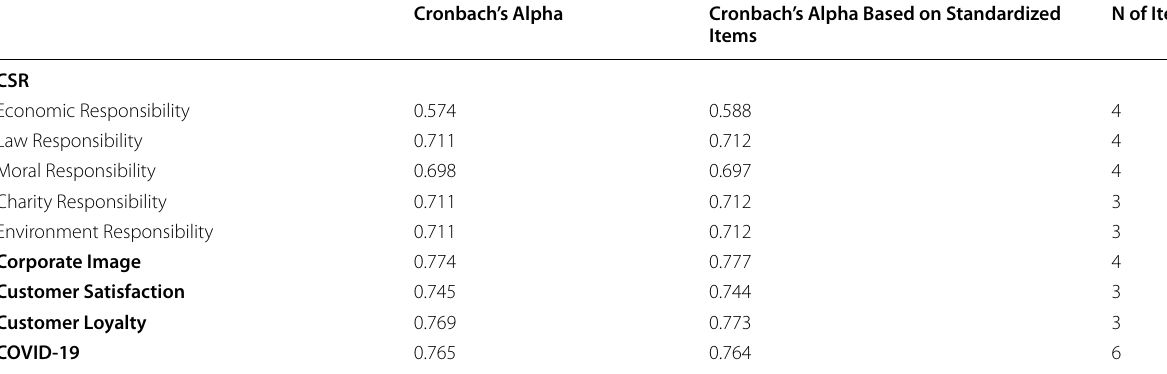
Table 4 Reliability Statistics